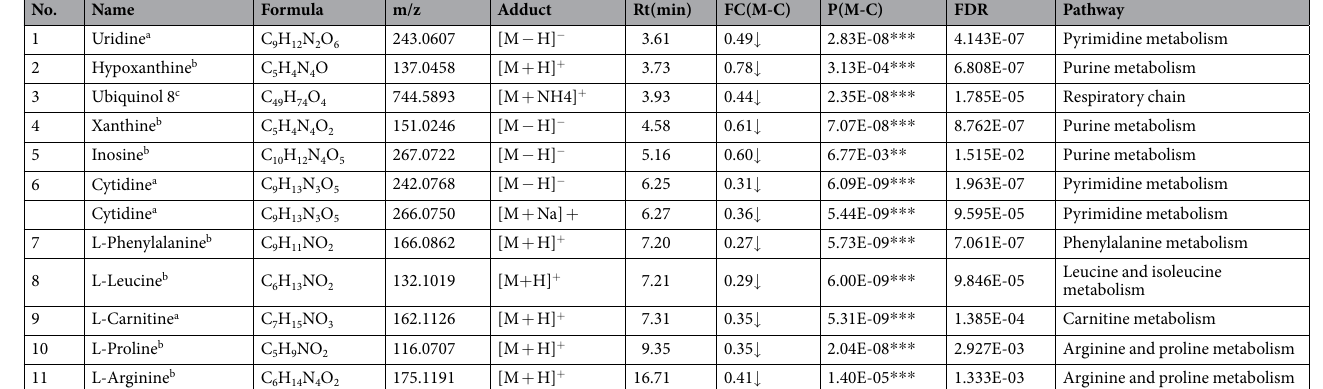
Table 2. Differential metabolites expressed in OVX group. a Metabolites analyzed based on MS/MS chromatograms. b Metabolites validated with standards. c Metabolites putatively annotated. ( ↓ ): down-regulated. ** p < 0.01, *** p < 0.001 versus